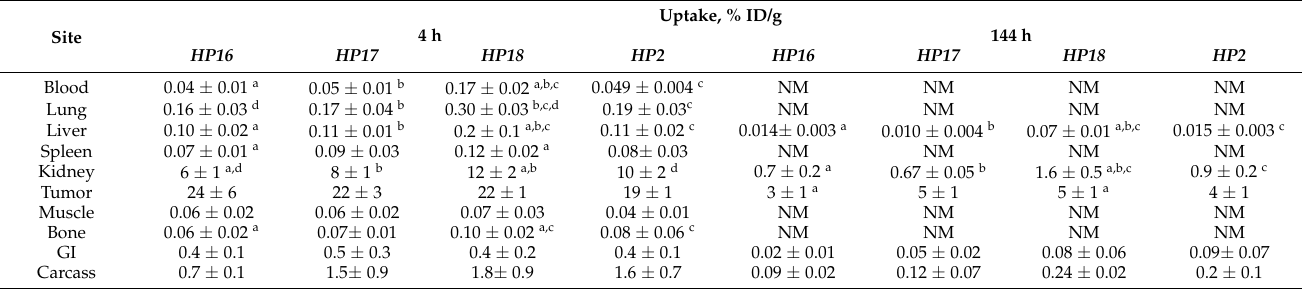
Table 5. Biodistribution comparison of new 177 Lu-labeled secondary probes in BALB/C nu/nu mice bearing SKOV3 xenografts at 4 and 144 h after injection. Primary agents (Z HER2:342 -SR- HP1 and Z HER2:342 -SR- HP15 , 50 µ g) were injected 16 h prior to 177 Lu-labeled secondary probe injection. The uptake is expressed as % ID/g and presented as an average value from 5 mice ± SD. One-way ANOVA with Bonferroni’s multiple comparisons test was performed to find significant differences.